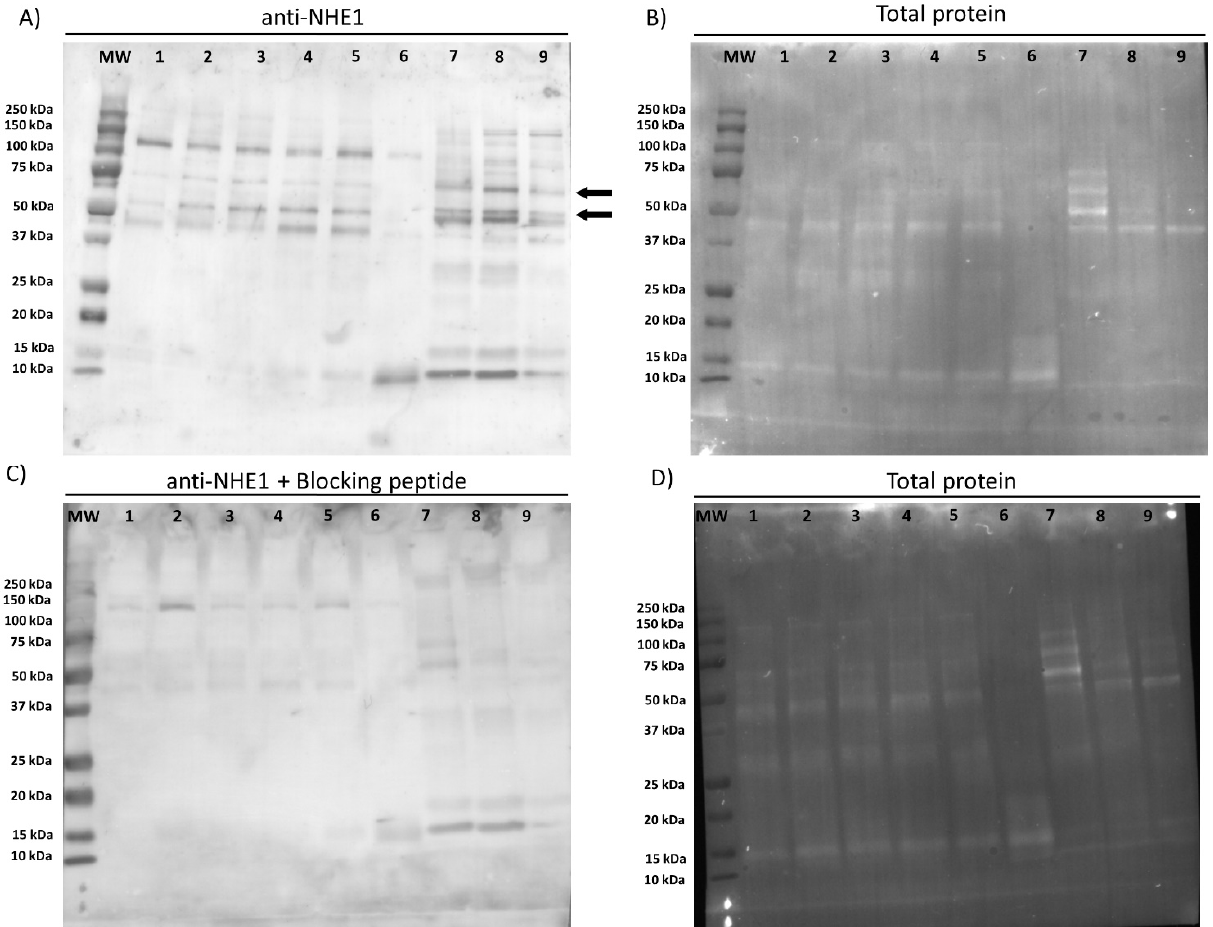
Figure 1. Representative immunoblotting for NHE1 ( A ), incubation of anti-NHE1 with the blocking peptide ( C ), and total protein content ( B , D ). Lanes: (MW) protein ladder; (1–6) sperm samples, each one corresponding to a different male; (7) pig ovary tissue sample; (8) pig oviduct tissue sample; (9) pig epididymis tissue sample.